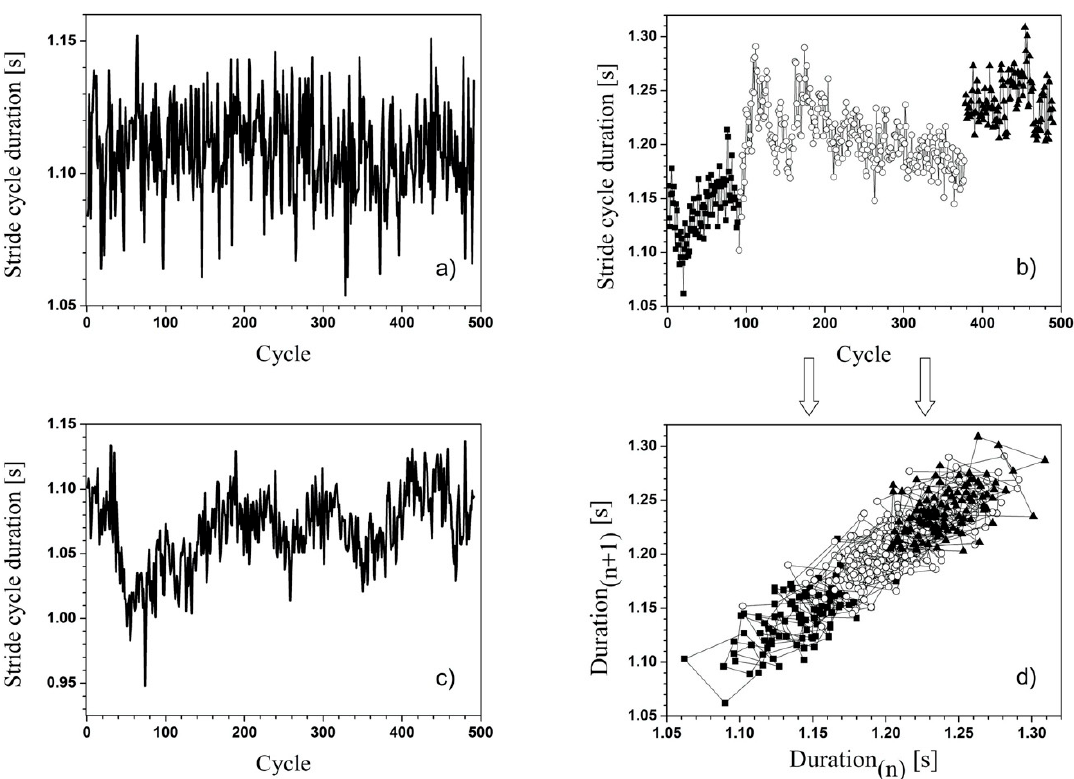
Figure 4. Some representative plots of the stride cycle duration during an entire walking test. All the displayed data are in WTS condition: ( a ) Very regular walking over the whole range; ( b ) a walking dataset clearly characterized by sharp “transitions” from a walking regime to another. Different regimes have been highlighted by using different point stiles (also to produce a clearer output for the plot in panel d)); ( c ) an intermediate situation between the two previous ones, characterizing most subjects; ( d ) 2D-projection of reconstructed trajectories in the phase-space produced by the data of panel b): the different symbols highlight the presence of local attractors for the orbits.